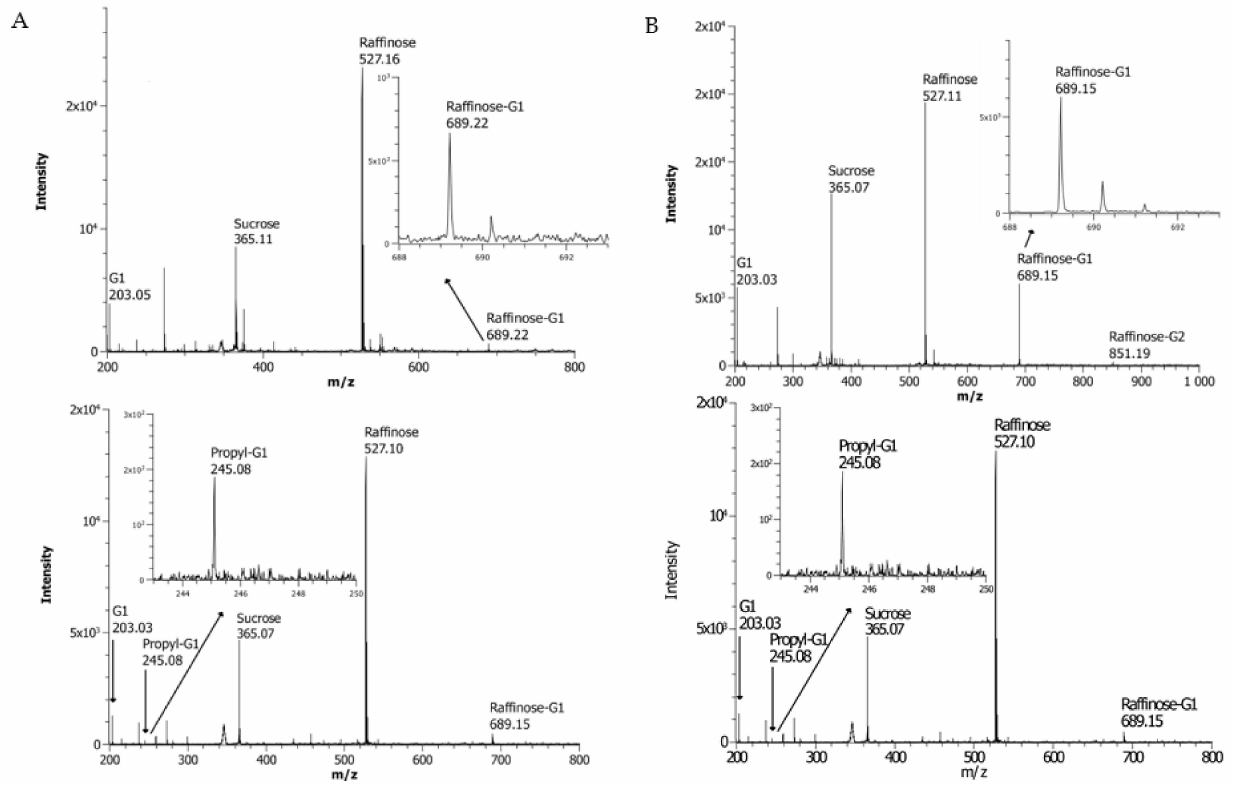
Figure 2. MALDI-TOF MS spectra of incubations with raffinose. In total, 12 nkat/mL BoGal36A panel ( A ) or 8 nkat/mL Aga27A panel ( B ) was incubated with 0.4 M raffinose alone (top) or with the addition of 5 v/v % propanol (bottom) at 37 ◦ C for 24 h. A peak corresponding to galactose (theoretical m / z for [m+Na + ]: 203.05), marked G1 in the spectra, was observed in all incubations. When incubated with raffinose alone, transglycosylation products were observed in the form of a tetrasaccharide (theoretical m / z for [m+Na + ]: 689.21) for Aga27A and BoGal36A. With propanol added, both enzymes had transglycosylation products in the form of propyl-G1 (theoretical m / z for [m+Na + ]: